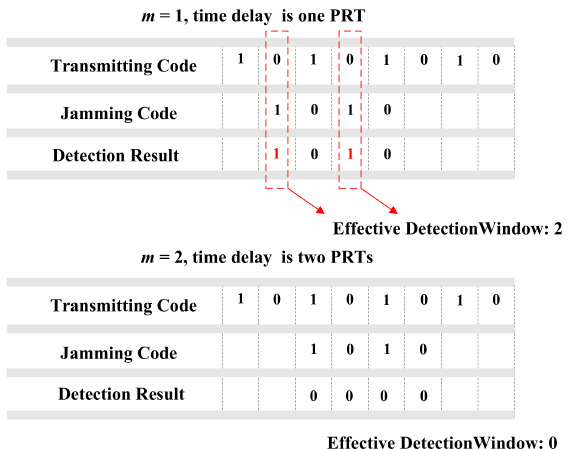
Figure 3. The example of transmitting time sequence encoding